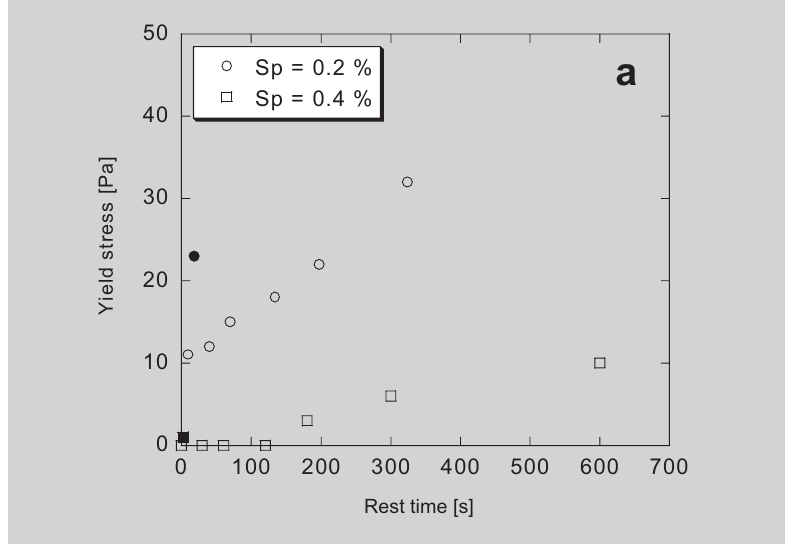
fume. Filled symbols are used for the final mea-